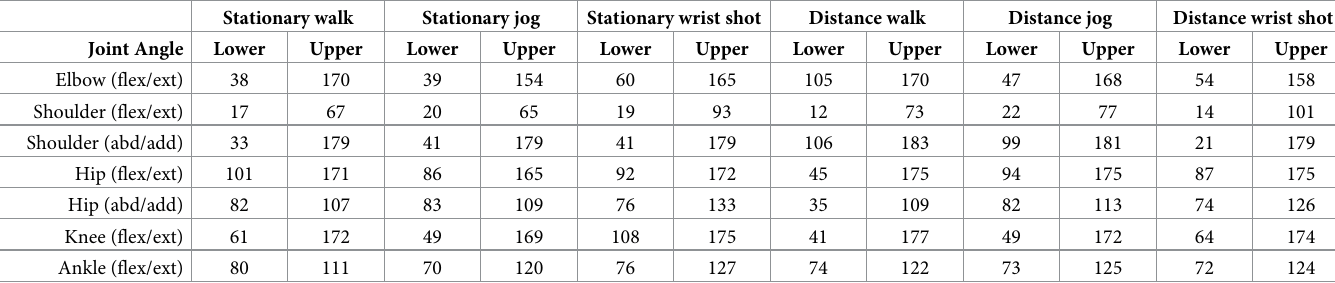
Table 8. Range of joint angles tested for each